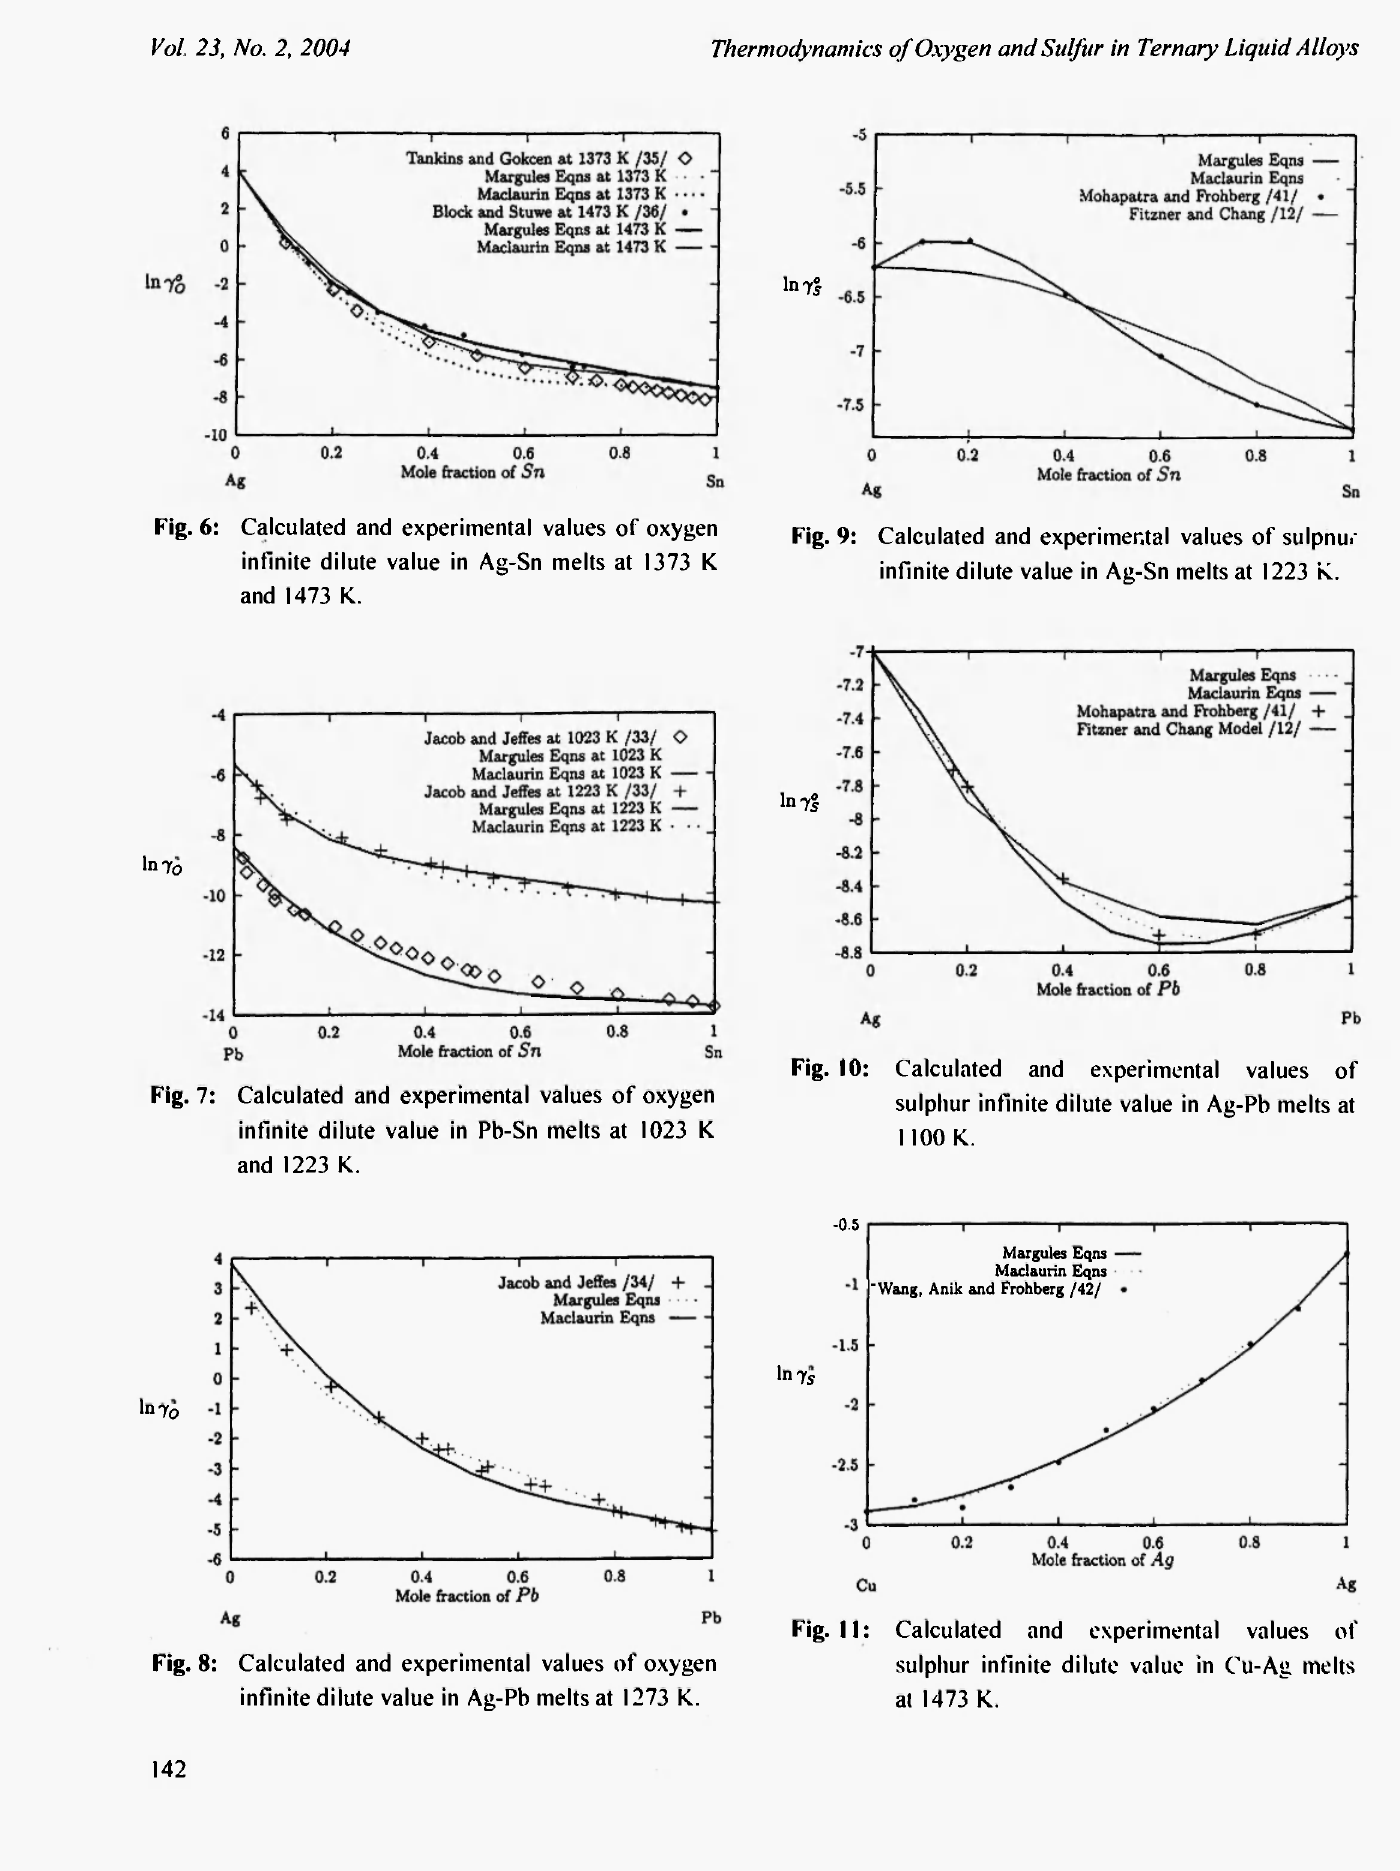
Fig. 8: Calculated and experimental values of oxygen infinite dilute value in Ag-Pb melts at 1273 K.